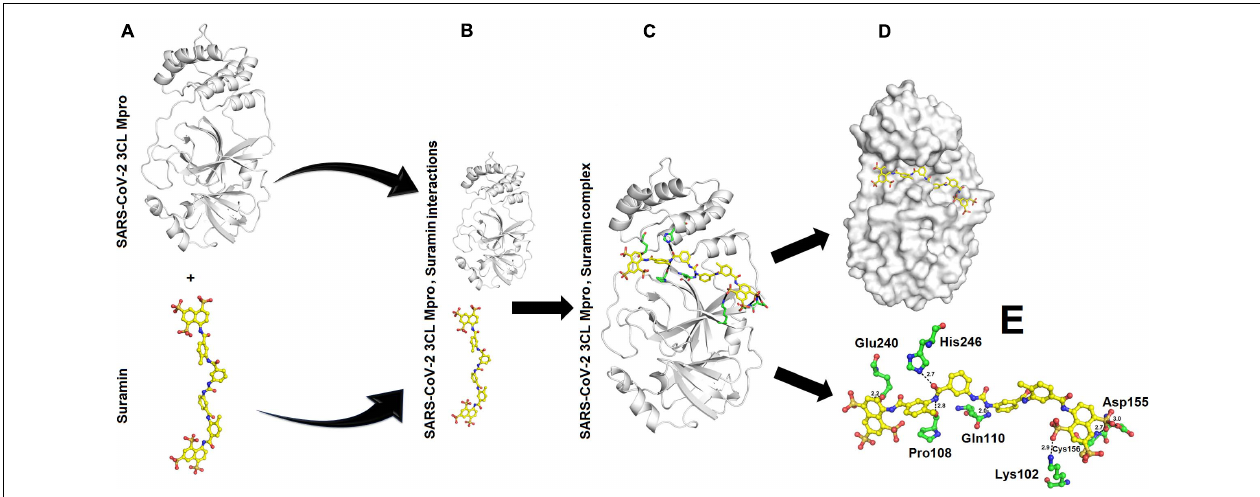
FIGURE 2 | Interaction between SARS-CoV-2 3CL M pro and Suramin: (A) Structure of SARS-CoV-2 3CL M pro and Suramin (B) SARS-CoV-2 3CL M pro and Suramin approaching each other (C) SARS-CoV-2 3CL M pro , Suramin complex (D) Suramin (shown as yellow sticks) residing in the cleft of SARS-CoV-2 3CL M pro between domains II and III (E) Amino acid residues (shown as green sticks) of SARS-CoV-2 3CL M pro interacting with Suramin (yellow sticks).